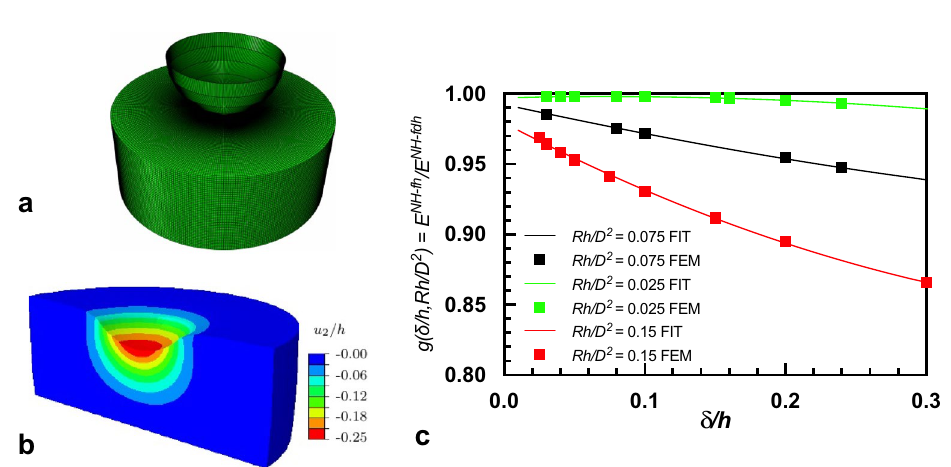
Figure 4. ( a , b ) FEM analysis was performed using ABAQUS choosing a finite element quad-mesh composed by 64,000 elements ( a ) Normal displacement shown for PAA6 ( b ). The simulation was performed to calculate both the elastic modulus and the normal displacement exerted on the hydrogel by the indenting sphere. ( c ) The evolution of correction factor g ( δ/h,Rh/D 2 ) with strain ( δ/h ) for different values of the finite diameter and also given by the empirical